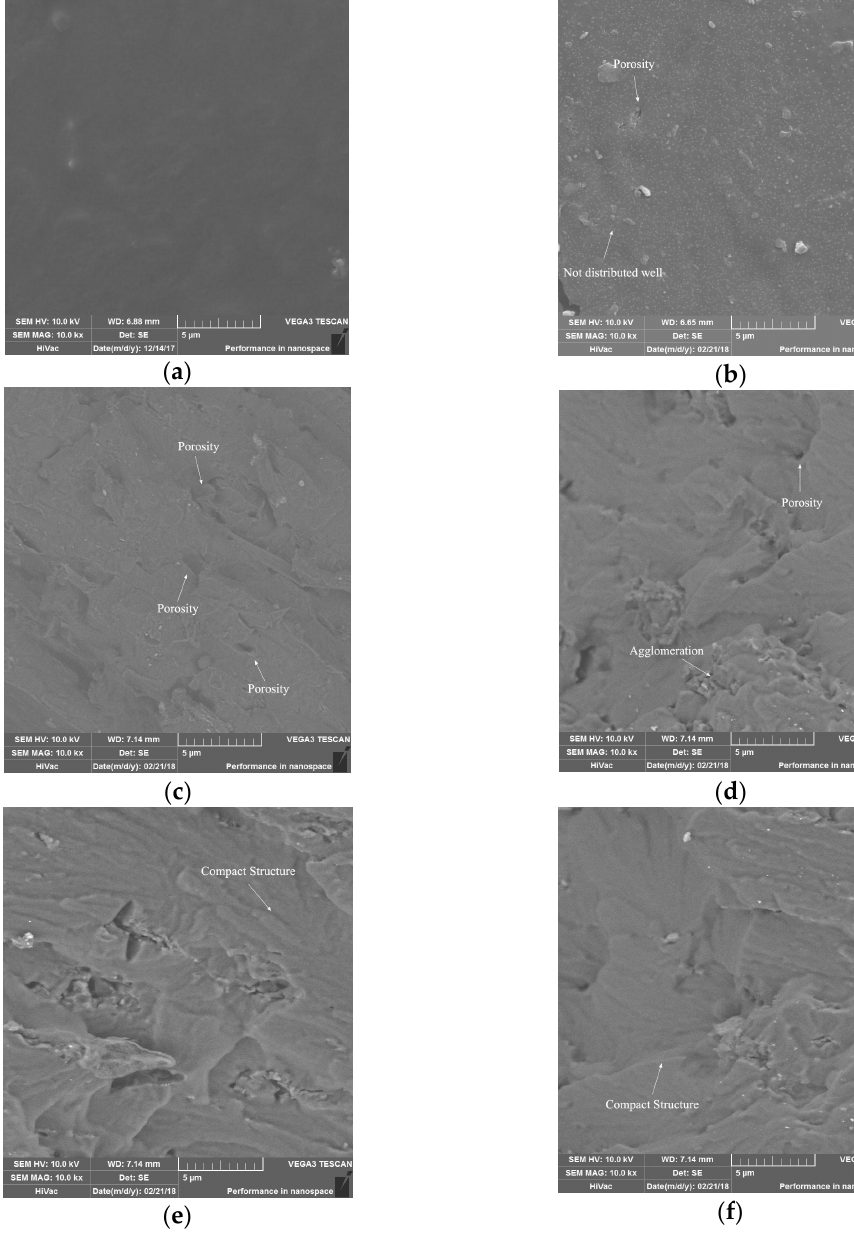
Figure 2. SEM images of fractured surface: ( a ) pure thermoplastic starch (TPS) film; ( b ) TPS reinforced 1 wt %; bionanocomposites with different UVT: ( c ) 0 min (untreated); ( d ) 15 min; ( e ) 30 min; and ( f ) 60 min.